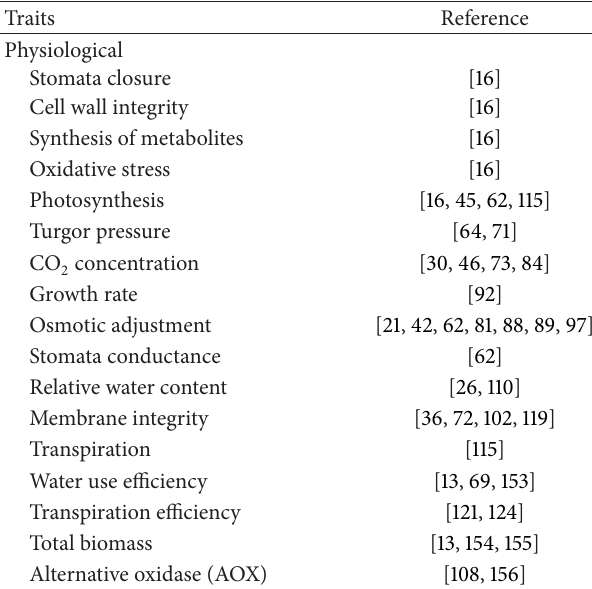
Table 3: Research scenario of physiological traits under drought stress in wheat.